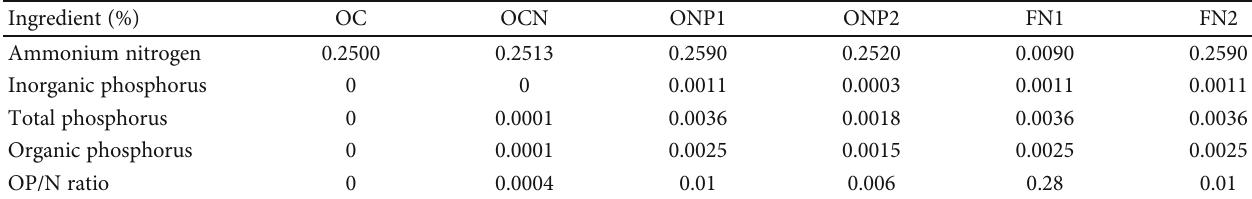
Table 2: Chemical characteristics in the six